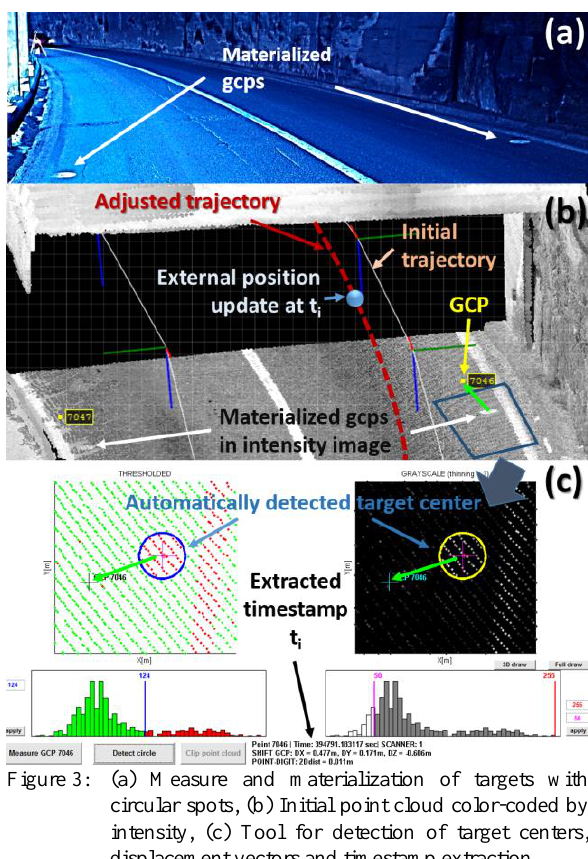
Figure 3: (a) Measure and materialization of targets with circular spots, (b) Initial point cloud color-coded by intensity, (c) Tool for detection of target centers, displacement vectors and timestamp extraction